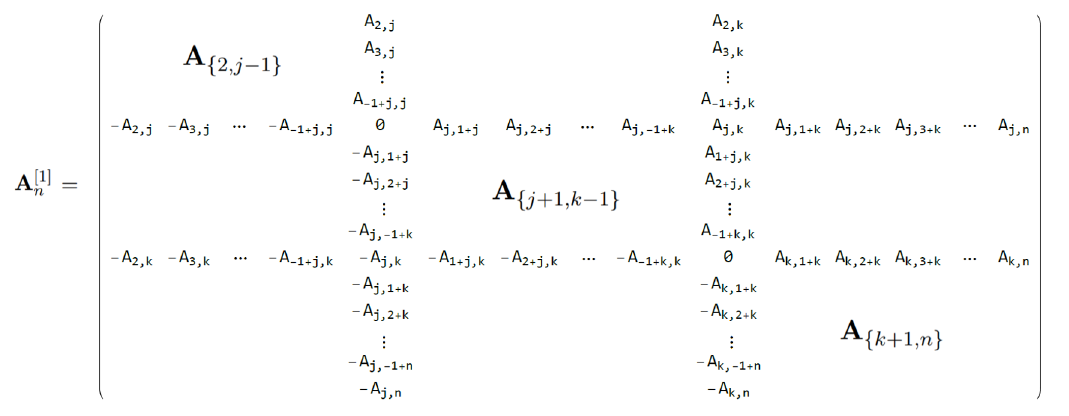
Figure 7 . General form of the matrix A [1]